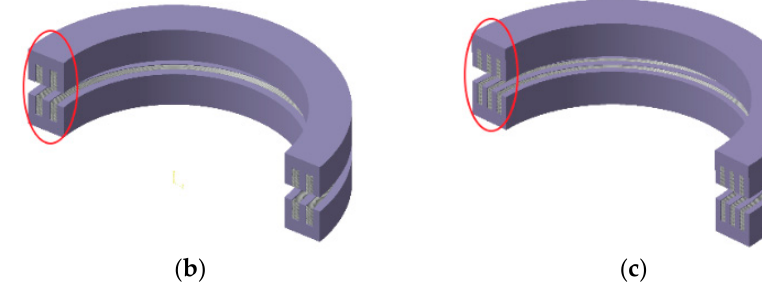
Figure 1. Cross-sectional view of the magnetic coupling structure of the three structures. ( a ) U- shaped; ( b ) E-shaped; ( c ) UE-shaped. ( b ) E-shaped; ( c )